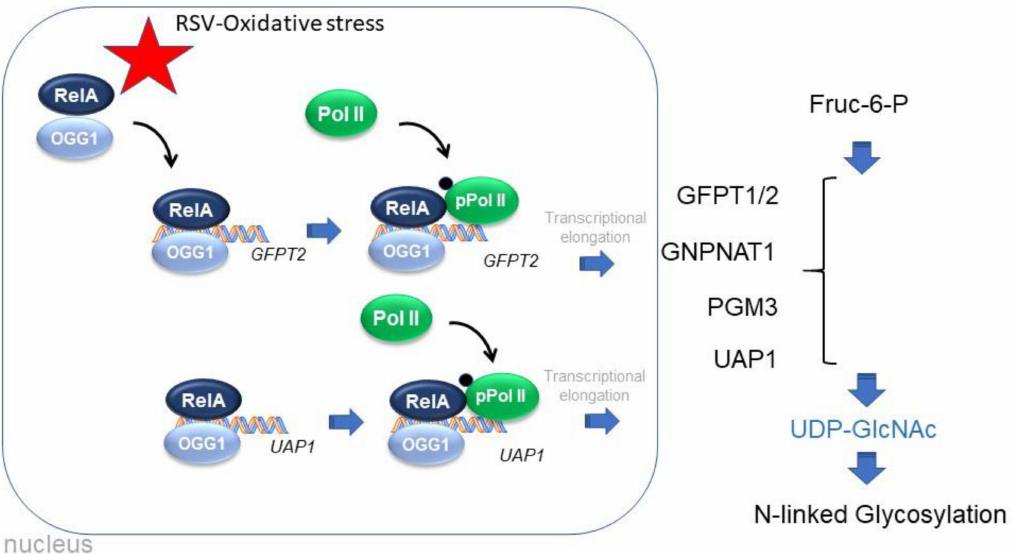
Figure 11. Graphical summary. Schematic of effects of RSV-induced oxidative stress on the formation of a RELAOGG1 complex that binds to nucleosome-free domains in the HBP regulatory regions. OGG1 activity is required for the RELA recruitment and association of the transcriptional elongation- competent form of phosphorylated RNA Pol II. HBP enzymes GFPT1/2, GNPNAT1, PGM3 and UAP1 catalyze the conversion of fructose-6 phosphate into UDP-GlcNAc, required for N-linked glycosylation of integrins and basal lamina